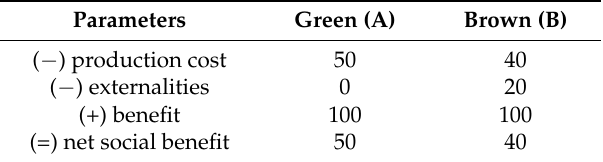
Table 2. Parameters for the green (A) and brown (B) goods (in experimental